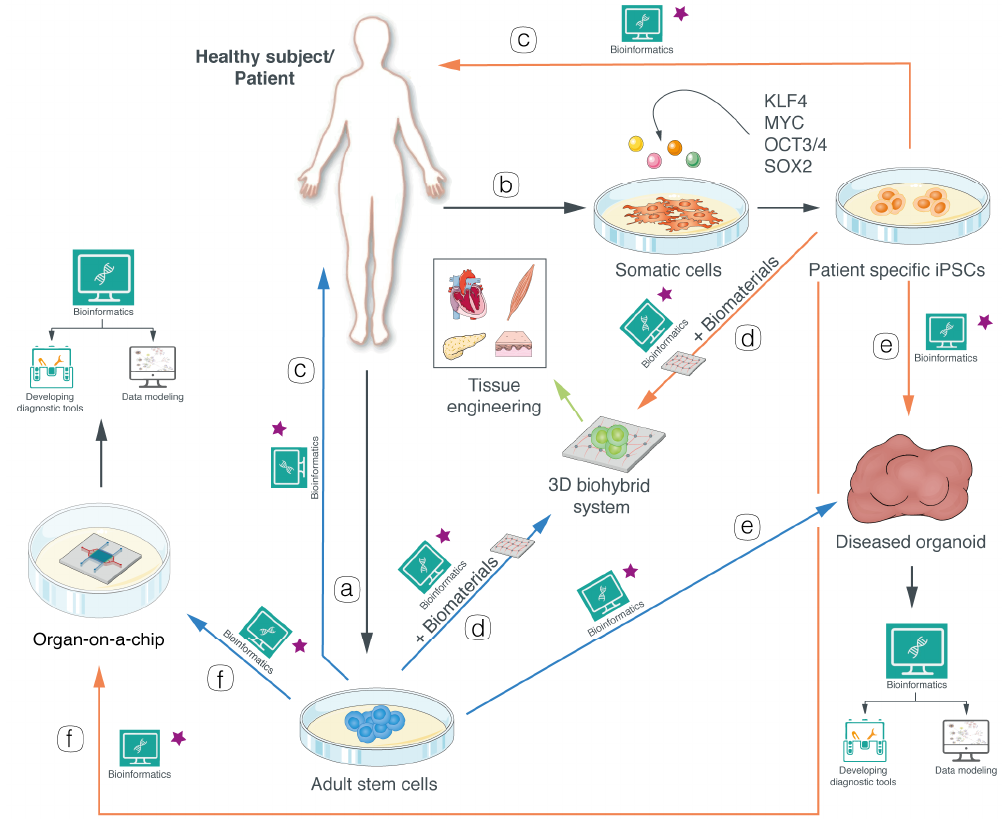
Figure 1. Schematic of ex vivo stem-cell based modeling systems. ( a ) Autologous stem cells from a donor heathy subject/patient, and patient-specific induced pluripotent stem cells (iPSCs) ( b ), may be source for generating: ( c ) Committed/differentiated cells; ( d ) 3D-biohybrid system; ( e ) organoids; and ( f ) organ-on-a-chip. The presence of computer icons indicates the critical role of the computational tools on the model design and the data elaboration. , indicates the application of gene therapy and/or CRISPR/Cas9 to each system.